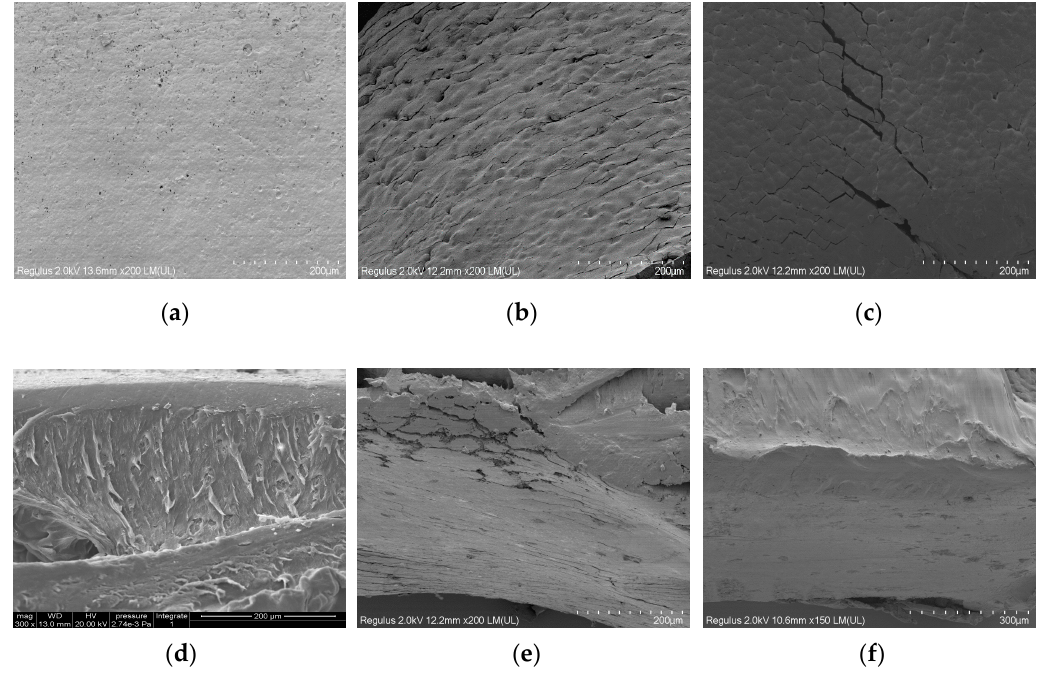
Figure 7. The SEM photographs o of PLLA and modified PLLA films: ( a ) surface of PLLA film; ( b ) surface of m − PLLA − 3; ( c ) surface of m − PLAG − 3; ( d ) cross section of PLLA film; ( e ) cross section of m − PLLA − 3; ( f ) cross section of m − PLAG − 3.